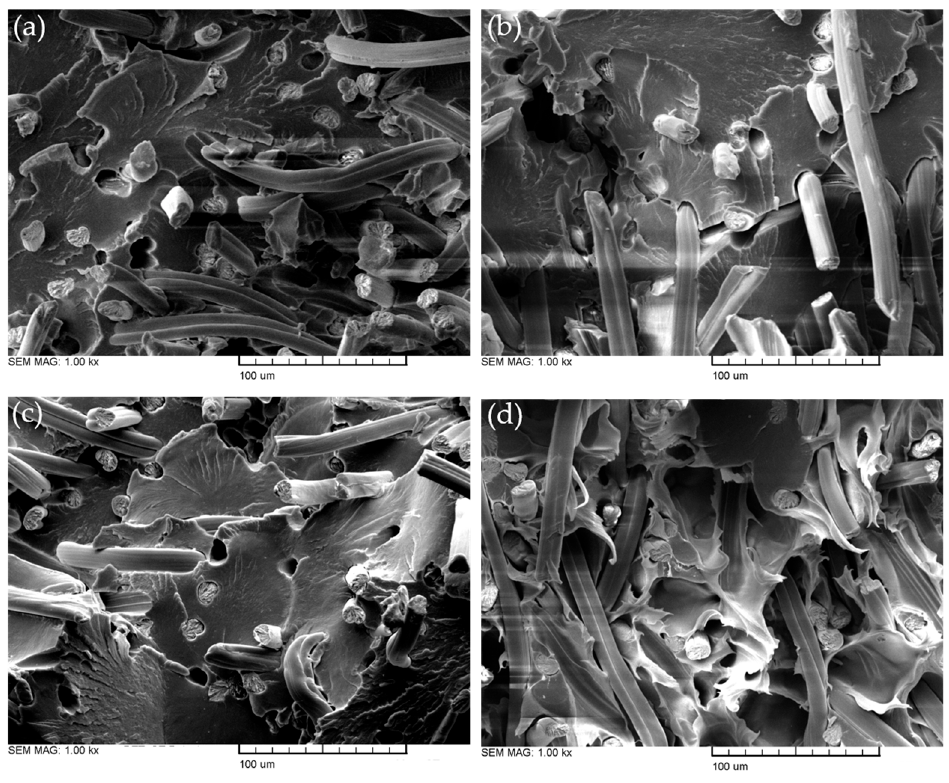
Figure 5. SEM pictures of PA5.10 RCF20 S504 ( a ), T504 ( b ), H504 ( c ), and W504 ( d ).